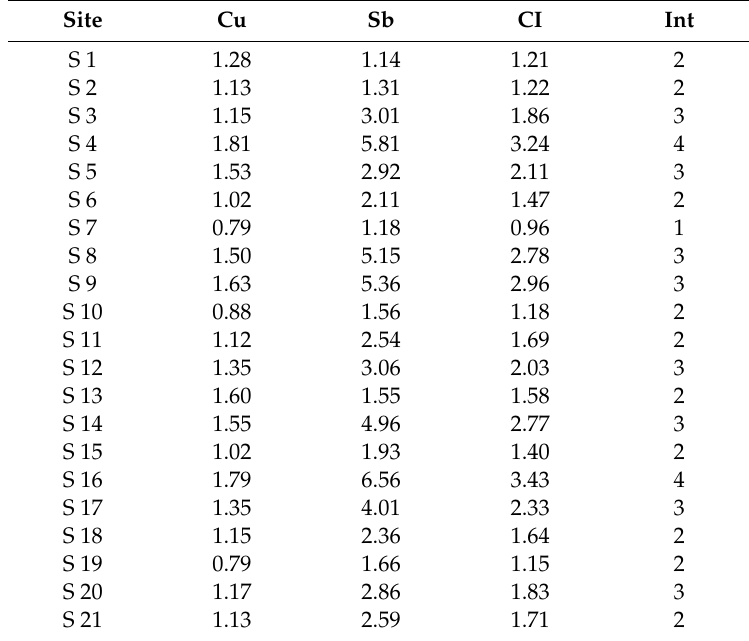
Table 2. Exposed-to-control (EC) ratios of Cu and Sb, and contamination index (CI) for each sampling site (S), as well as interpretation (Int) of CI values according to the scale of Cecconi et al. [10]: 1 = absence of contamination, 2 = low contamination, 3 = moderate contamination, 4 = high contamination.